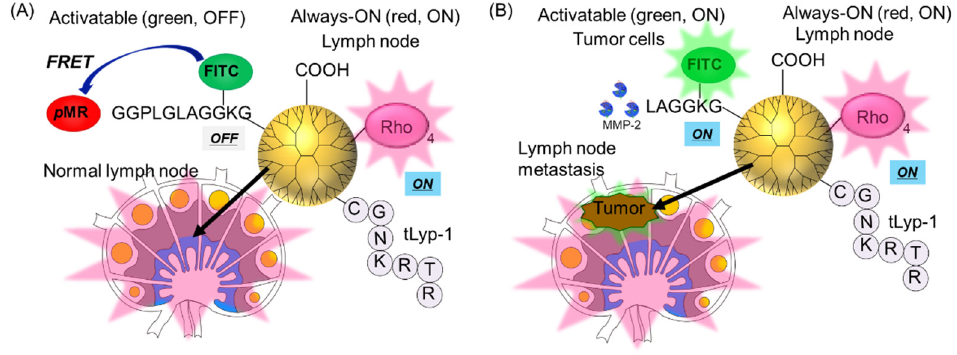
Figure 1. Design of a dual-color fluorescent carboxyl-terminal dendrimer featuring a tumor-homing peptide (tLyp-1), rhodamine B (Rho) as an always-ON probe, and a matrix metalloprotease − 2 (MMP − 2) substrate peptide combined with a quencher ( p MR) and a fluorophore (FITC) at both ends as an activatable fluorescence probe. Using the probe, single- and dual-color fluorescence signals can be observed from normal lymph node ( A ) and metastatic tumor cells-containing lymph node ( B ), respectively.